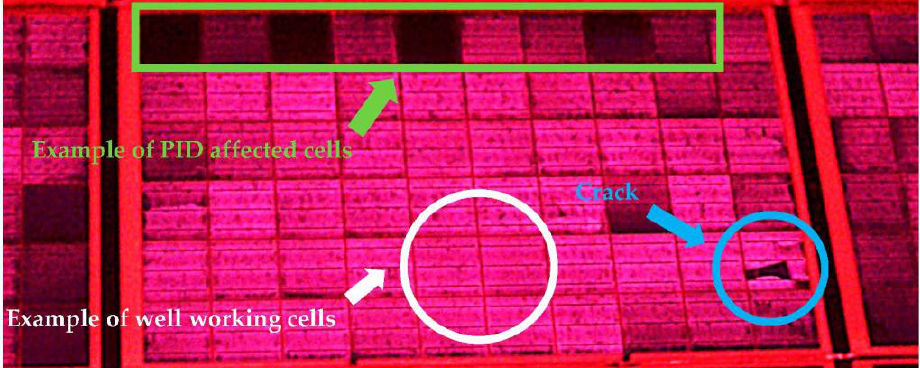
Figure 3. EL image of a c-Si module affected by potential induced degradation (PID) and cracks. PID a ff ected cells are black or partially dark with an inhomogeneous luminescence.